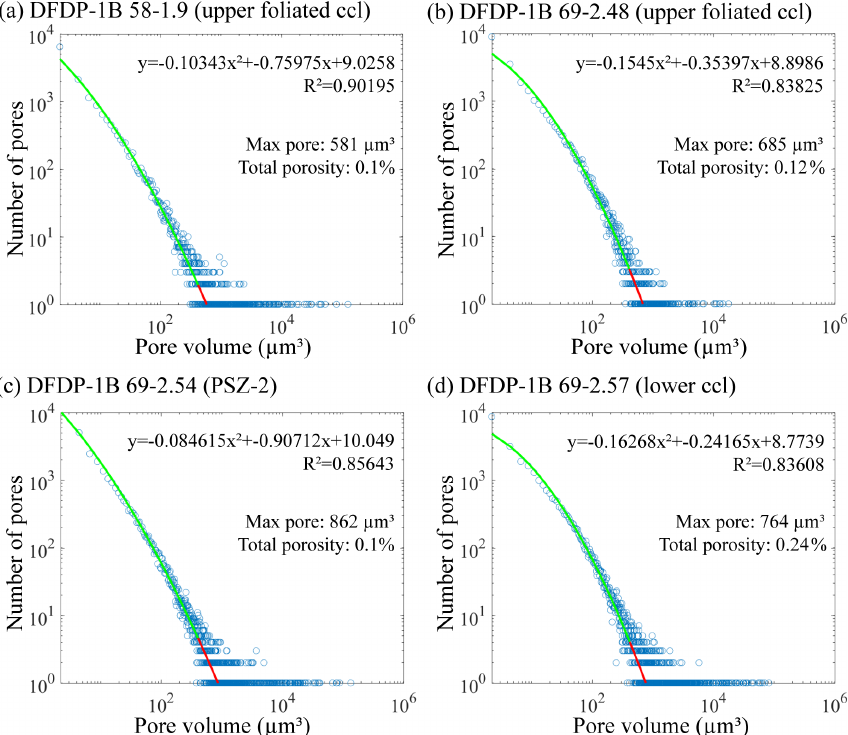
Figure 3. Plots of pore volume vs. number of pores for each sample. Estimates of total porosity and size of the maximum expected pore are also shown, as well as the curve fitting function for each